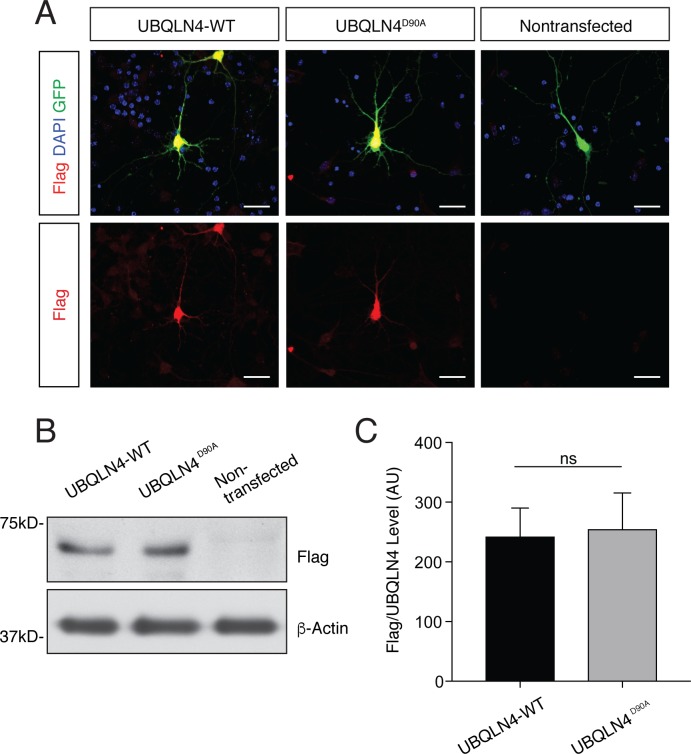
UBQLN4-WT and UBQLN4D90A are expressed at similar levels in primary mouse motor neurons and in zebrafish embryos.(A) Representative images of primary mouse spinal cord neurons transfected with pCAG-GFP and Flag-tagged UBQLN4-WT or UBQLN4D90A, stained with anti-Flag antibody (red) and DAPI (blue). Scale bar: 20 μm. (B) Western blot of UBQLN4/Flag levels from zebrafish embryos injected with UBQLN4-WT or UBQLN4D90A mRNA, and uninjected controls. Actin Western blot indicates equal protein loading. (C) Quantification of Flag signal in (B) confirmed that UBQLN4-WT and UBQLN4D90A mRNAs are expressed at similar levels (p=0.77). Data are from three independent experiments and are mean ± SEM. ns: p>0.05, two-tailed Student’s t-test.